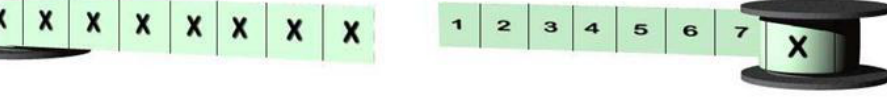
Figure 5: Left: Shows a spool for candidate X. Note that the candidate’s name will be written on every section of the spool. Right: Shows the back of candidate X’s spool. Election officials can find the number of votes by looking at the back of the last marked section, assuming the front of all previous sections were consecutively marked. Tallying can be achieved in a relatively short time compared to regular paper